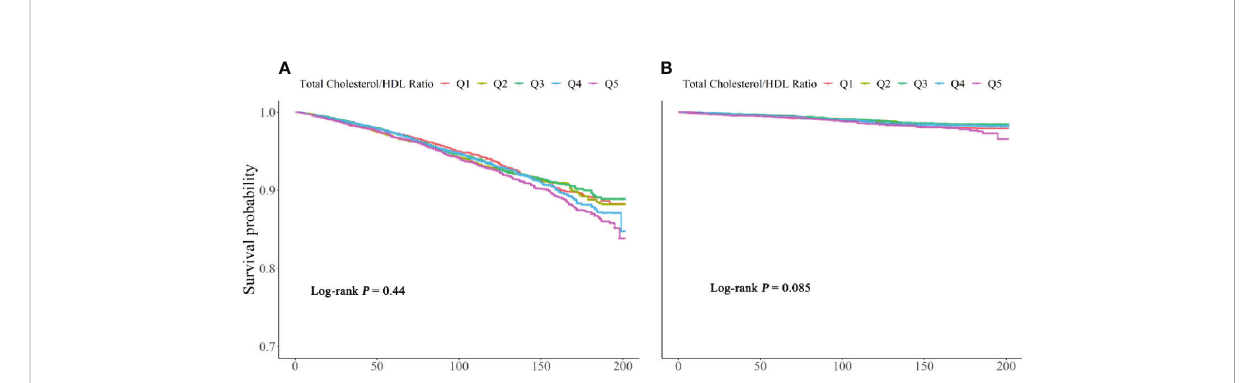
FIGURE 3 Kaplan – Meier survival curves for all-cause (A) and cardiovascular (B) mortality between Q1, <2.86, Q2, 2.86 – 3.46, Q3, 3.46 – 4.12, Q4, 4.12 – 5.07, and Q5, >5.07.